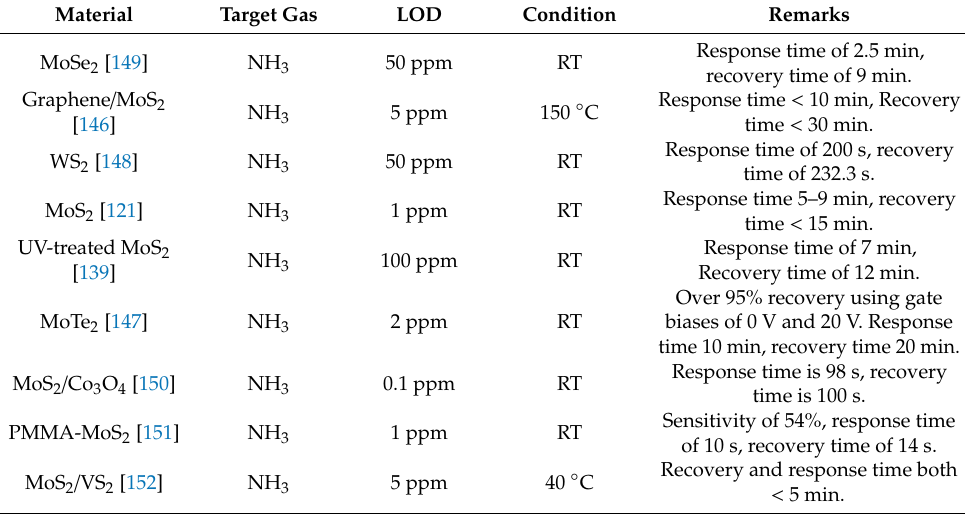
Table 3. Ammonia gas sensing TMDC materials and their performances.